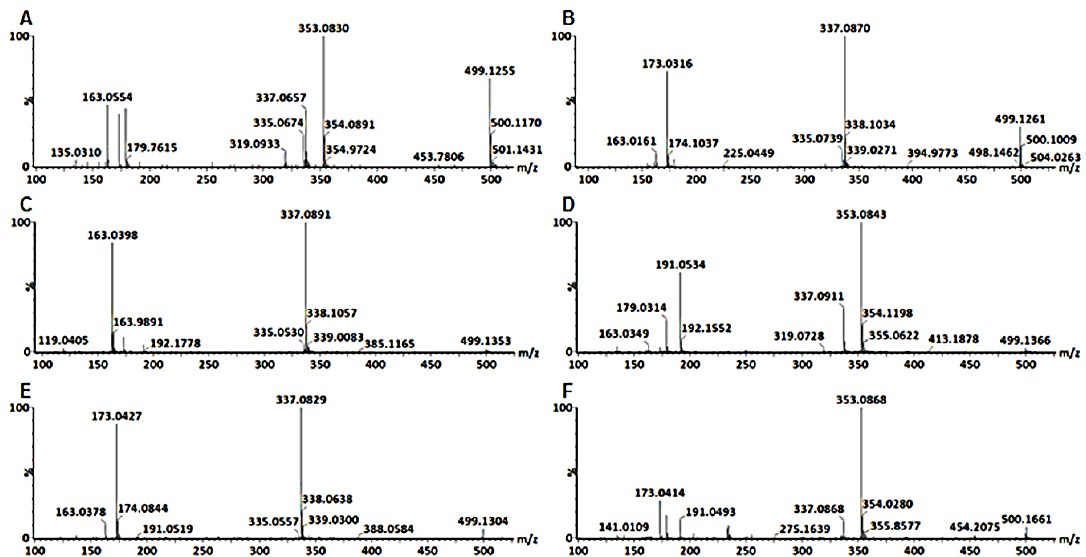
Figure 4. Typical mass spectra of the fragmentation patterns of 3 ‐ coumaroyl ‐ 4 ‐ caffeoylquinic acid (A) , 3 ‐ caffeoyl ‐ 4 ‐ coumaroylquinic acid (B) , 3 ‐ coumaroyl ‐ 5 ‐ caffeoylquinic acid (C) , 3 ‐ caffeoyl ‐ 5 ‐ coumaroylquinic acid (D) , 4 ‐ coumaroyl ‐ 5 ‐ caffeoylquinic acid (E) and 4 ‐ caffeoyl ‐ 5 ‐ coumaroylquinic acid (F) .